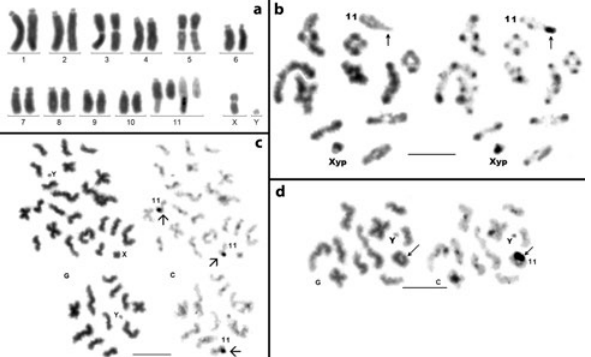
Fig. 1. Chromosomes of Dorcadion olympicum : a) Giemsa-stained karyotype and C-banded chromosomes 11 exhibiting additional heterochromatin in one homologue. b) Giemsa stained (left) and C-banded (right) spermatocyte I at diakinesis/metaphase with biva- lent 11 carrying heterochromatin at one side (arrow). X and Y form a parachute bivalent (Xyp). Barr= 10 mm, as in other figures. c) Group of 3 spermatocytes II at metaphase, sequentially Giemsa stained (G) and C-banded (c). As in most other metaphases II, centromeric het- erochromatin is poorly C-banded and chromosome 11 is asymmetri- cal, with compacted heterochromatin at the tip of a single chromatid (arrows). d) 12,Y spermatocyte II in which the 2 heterochromatin carrier chromatids of chromosome 11 remain cohesive, whereas all other chromosomes have clearly non-cohesive chromatids.